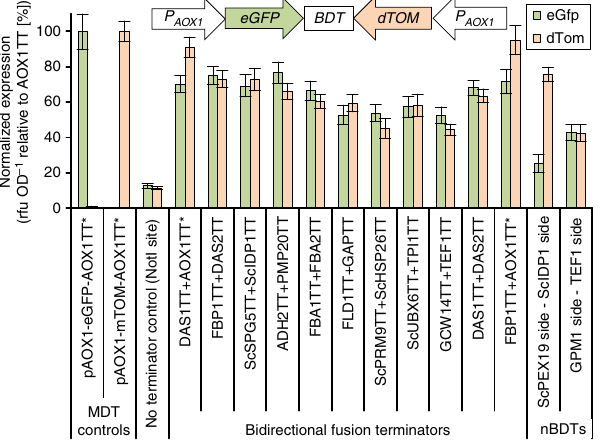
Fig. 7 Bidirectional transcription terminators (BDTs) required for the assembly of bidirectional multi-gene co-expression relieve expression loss associated with transcriptional collision. A reporter construct for testing bidirectional transcription termination was assembled by cloning the genes coding for eGfp and dTom in convergent orientation (small inlet). Two AOX1 promoters were used to drive equal expression of the reporter genes. Monodirectional terminators (MDTs) were combined into bidirectional fusion terminators and two putative natural BDTs (nBDTs) were tested. A negative control lacking termination sequences and bearing solely a Not I restriction site was included. Additional control constructs contain only a single AOX1 promoter, a single FP, and the AOX1* terminator. AOX1TT* denotes the AOX1 terminator sequence used by Vogl et al. 30 . Some BDTs acted also as autonomously replicating sequences (Supplementary Fig. 7). Mean values and standard deviations of fl uorescence measurements after pre-growth on glucose followed by methanol induction of biological quadruplicates are